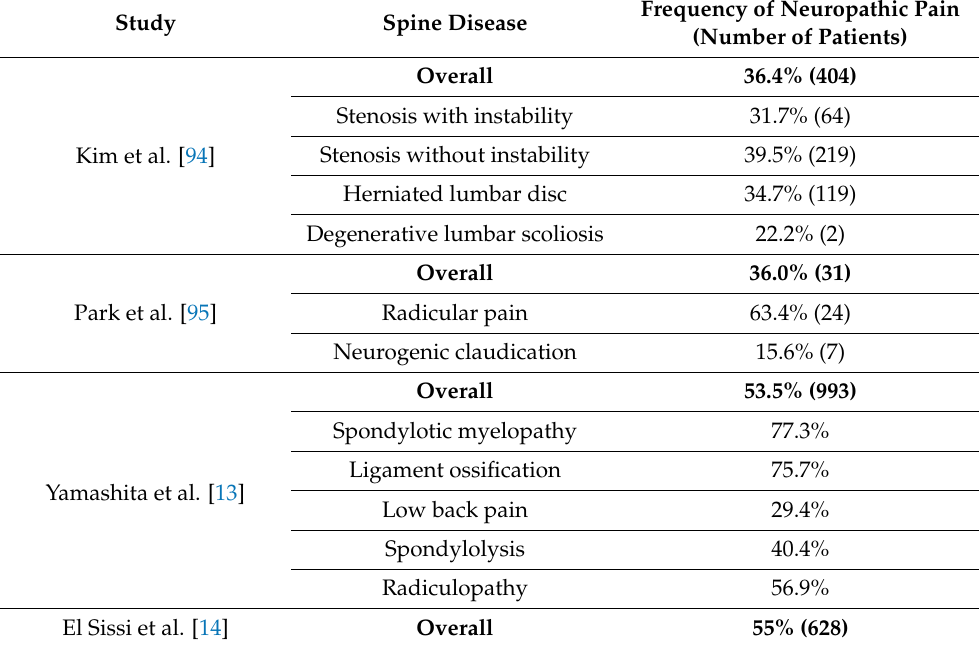
Table 1. Frequency of neuropathic pain in patients with spine disorders investigated by epidemi- ological studies. Study Spine Disease